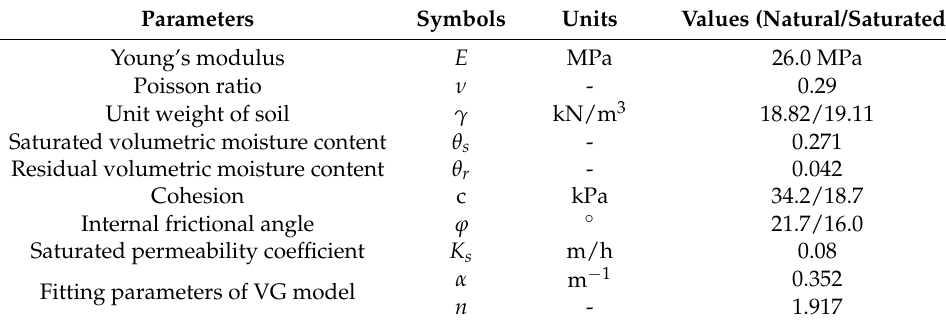
Table 2. Details of experimental design.